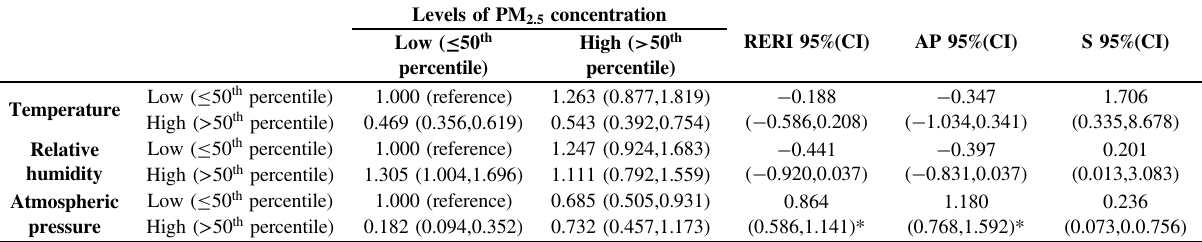
Table 3 Adjusted OR (95%CI) for AMD by additive interaction analysis of meteorological factors and PM 2.5 levels. Levels of PM 2.5